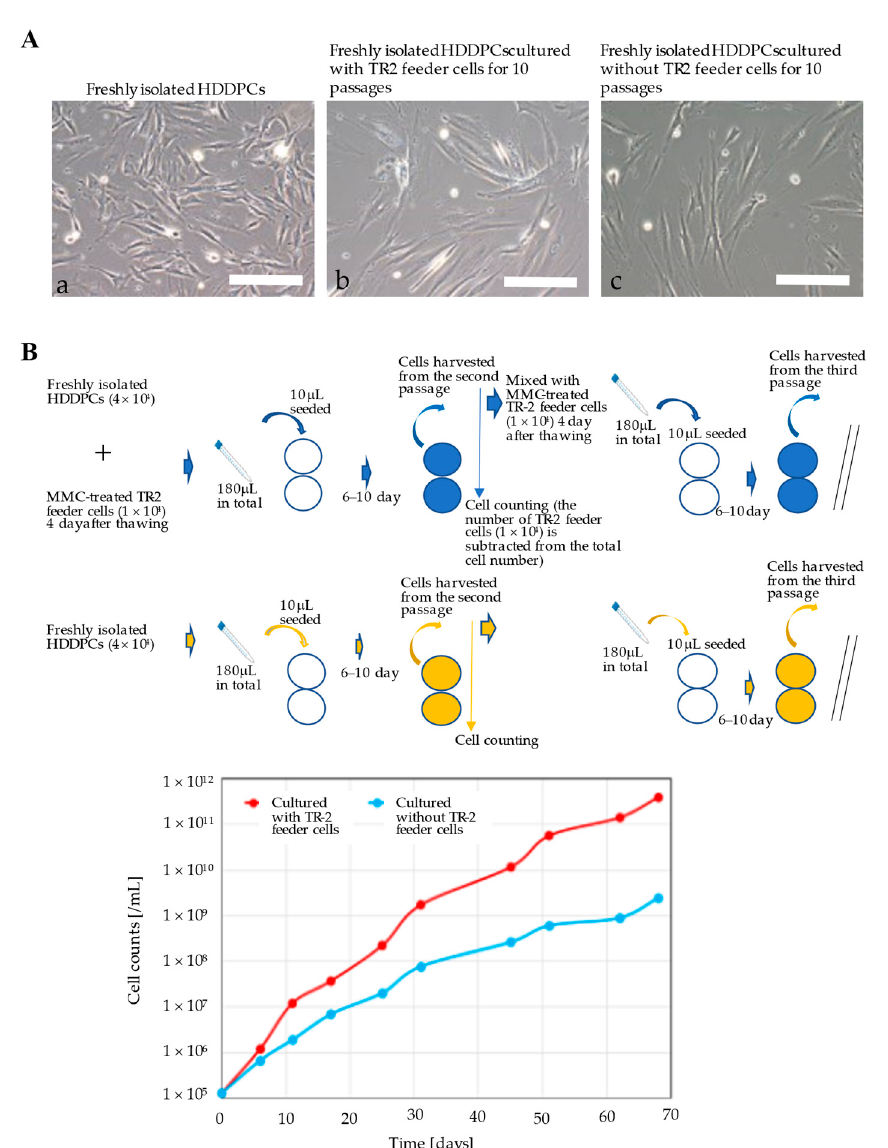
Figure 3. Characterization of freshly isolated primary HDDPCs cultured with or without TR-2 feeder cells (I). ( A ) Morphology of primary HDDPCs (a) before transfection, (b) cultured with TR-2 feeder cells for 10 passages, and (c) cultured without TR-2 feeder cells for 10 passages. Scale bars = 100 µm. ( B ) Proliferation of primary HDDPCs with or without MMC-treated TR-2 feeder cells. The assay is shown schematically in the upper column. In the lower column, the proliferation rate after 10 passages is shown. Primary HDDPCs cultured with TR-2 feeder cells had a higher proliferation rate than those cultured without TR-2 feeder cells. HDDPC: human deciduous dental pulp cells; MMC: mitomycin-C.